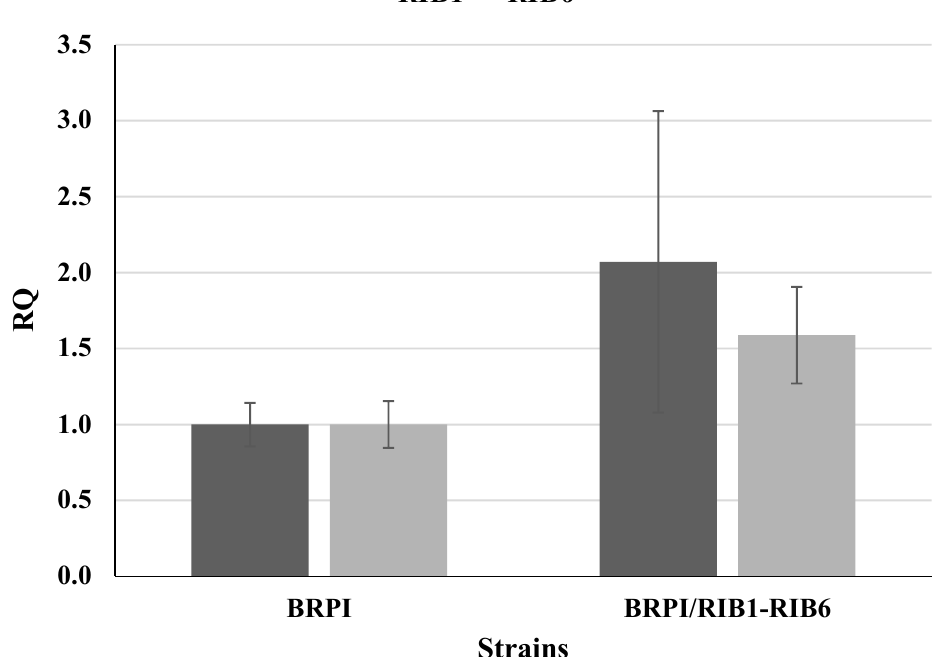
Figure 2. Relative quantification (RQ) of RIB1 and RIB6 genes. Strains BRPI and BRPI/RIB1-RIB6 were cultivated on YNB medium supplemented with yeast extract at 28 °C, 220 rpm. The mRNA quantification was normalized to ACT1 mRNA.